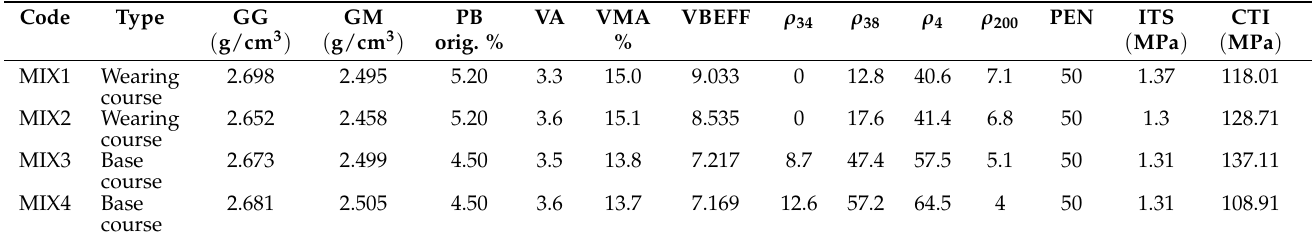
Table 10. Pre-qualification values of asphalt mixtures.